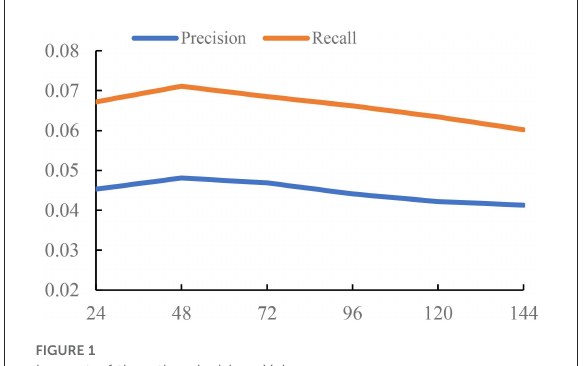
FIGURE1 Impact of time threshold on Yelp.